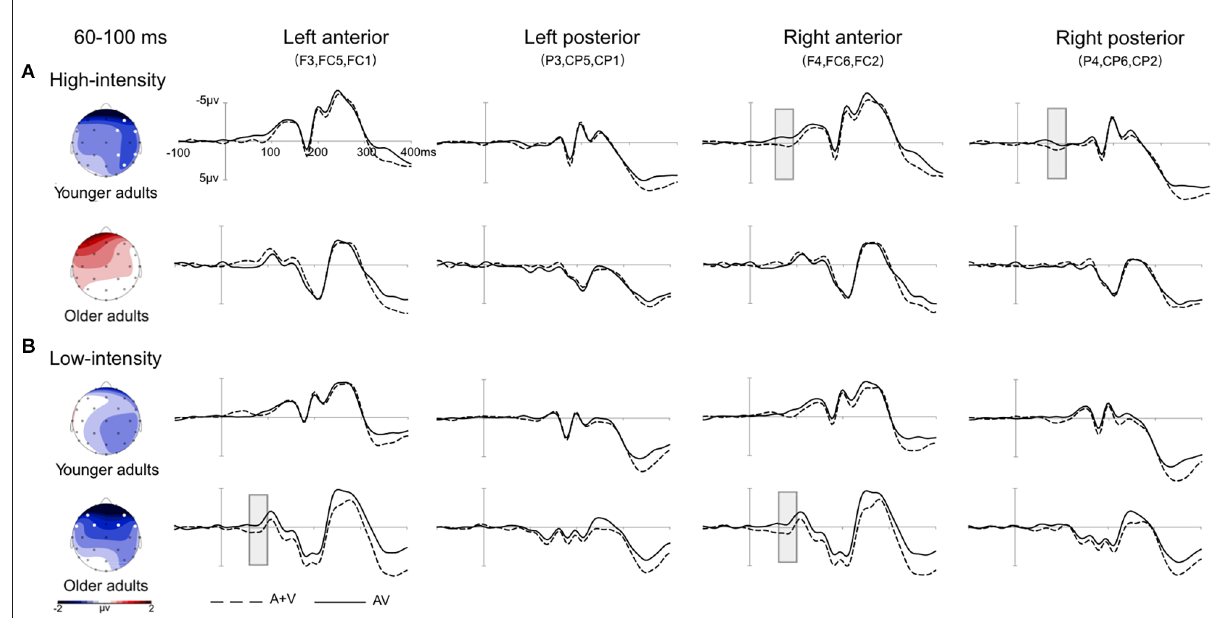
FIGURE2 Grand-averaged event-related potentials and topography map of audiovisual integration in the time window of 60–100 ms. Grand-averaged event-related potentials included the left anterior (F3, FC5, FC1), left posterior (P3, CP5, CP1), right anterior (F4, FC6, FC2), and right posterior (P4, CP6, CP2) regions. The solid line is the event-related potentials of the audiovisual stimulus (AV), and the dotted line is the sum of the event-related potentials of visual and auditory stimuli (A + V). The areas where audiovisual integration increases are marked with gray squares. The topographic map shows the difference between AV and A + V. (A) Under the high-intensity condition, audiovisual integration was greater in the right anterior and right posterior regions in young adults than in older adults. (B) Under the low-intensity condition, audiovisual integration in the left anterior and right anterior regions was greater in older adults than in younger